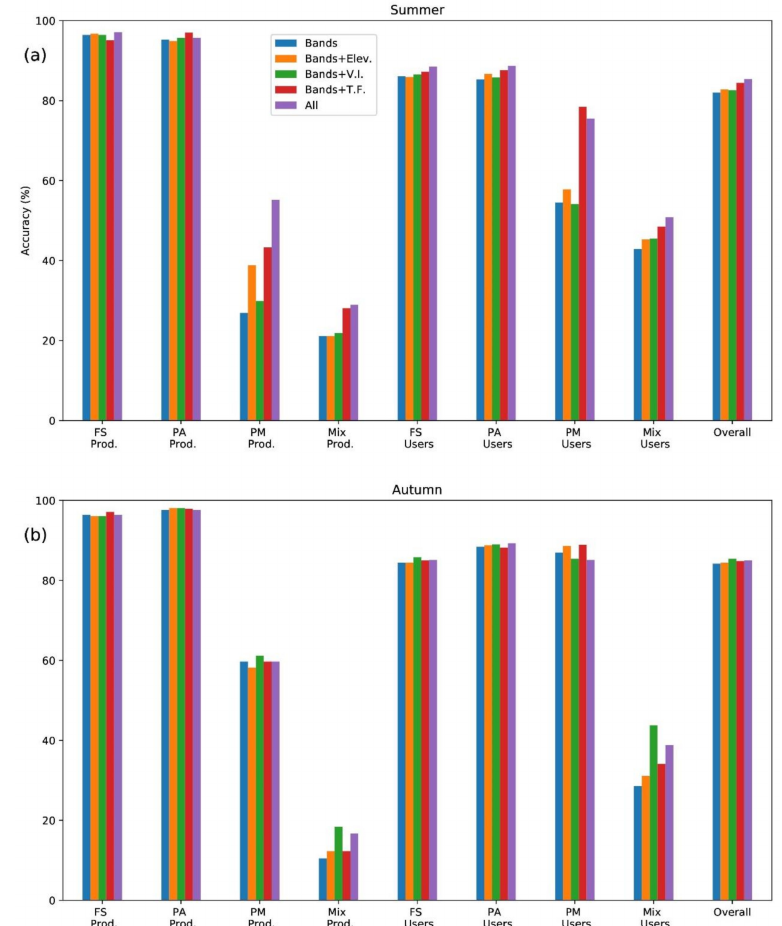
Figure 3. User’s, producer’s and overall accuracies resulting from Random Forest classification for Old-Growth Forest tree species for 5 selected models in ( a ) Summer (2 August 2017) and ( b ) Autumn (16 October 2017). Abbreviations: FS—Beech, PA—Norway spruce, PM—mountain